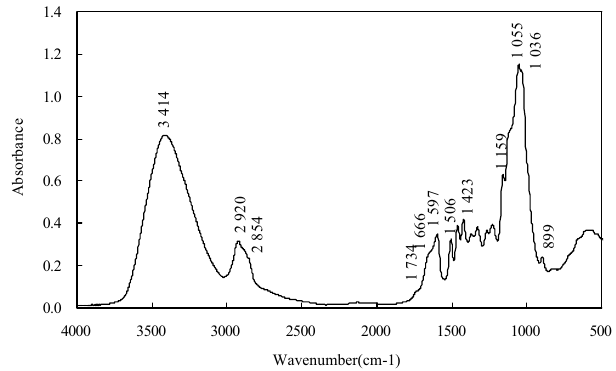
Figure 1. FTIR spectra of NaOH treated Michelia figo wood biomass.